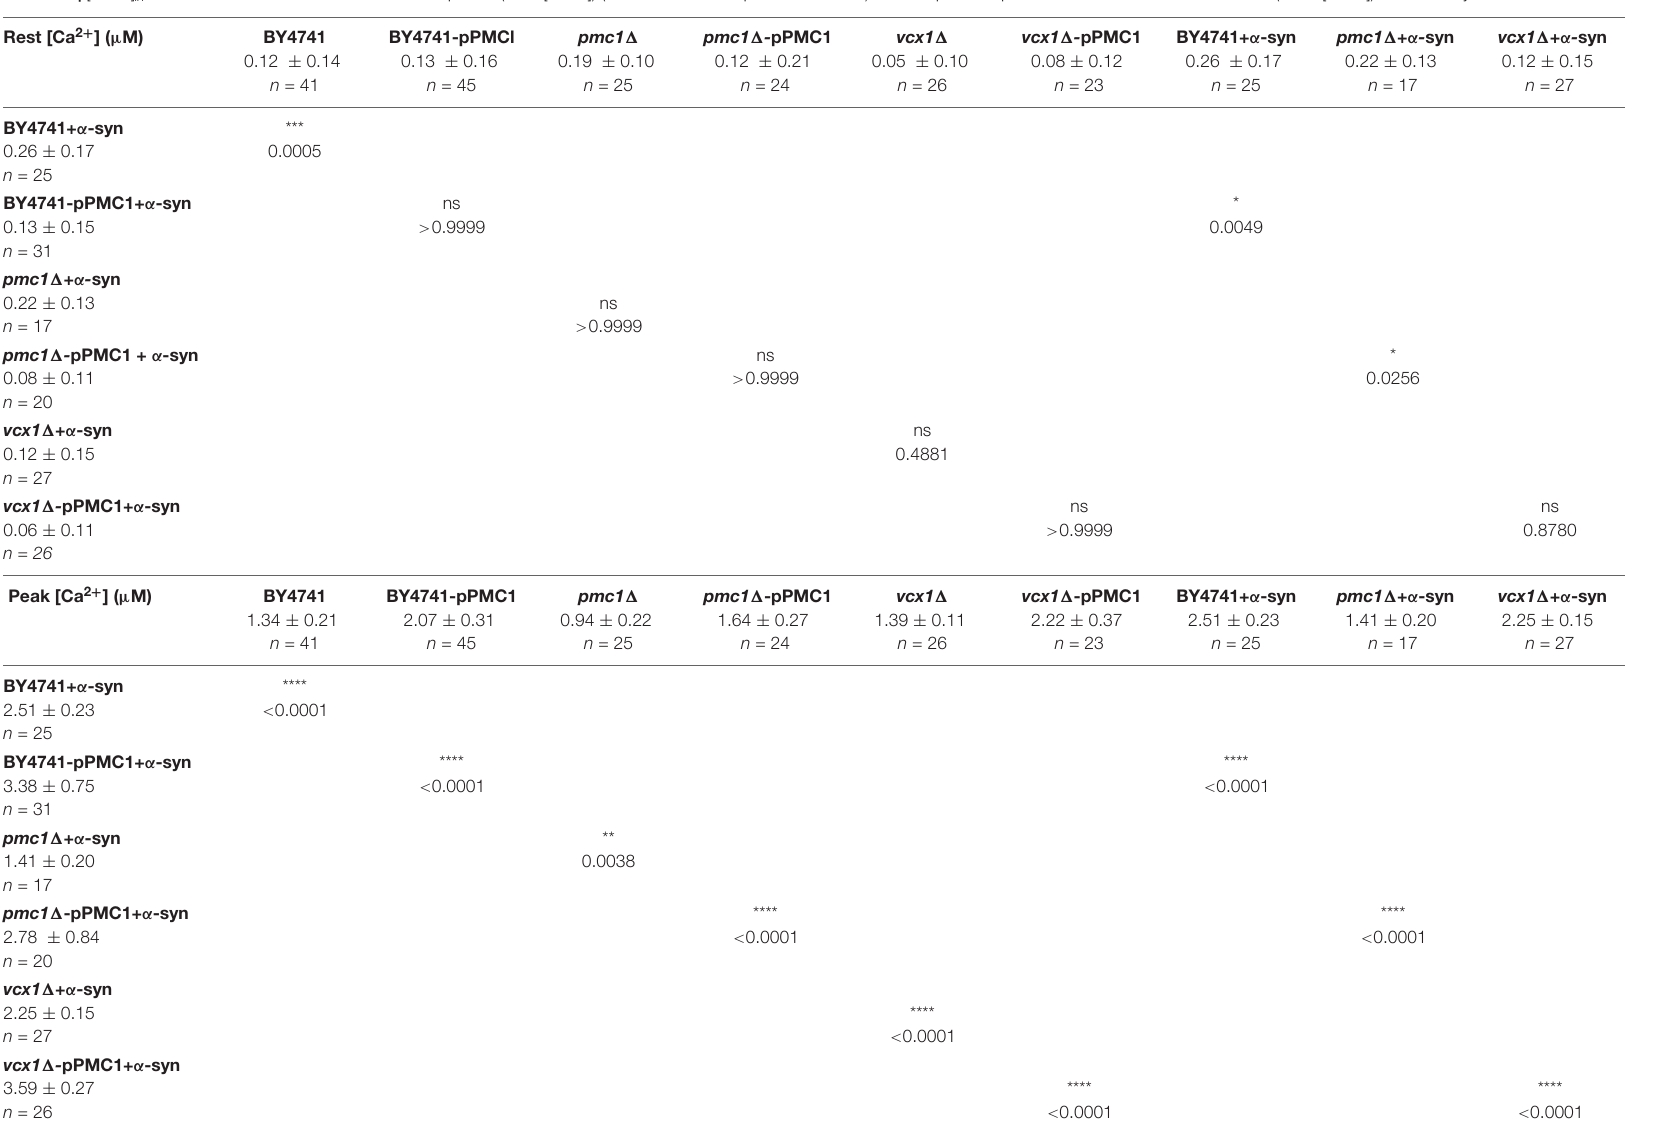
Data are mean and SD for n cultures (coverslips). Statistical differences were calculated using one-way ANOVA with Bonferroni posttest. ns (not significant) P > 0.05; *P ≤ 0.05; **P ≤ 0.01; ***P ≤ 0.001; ****P <